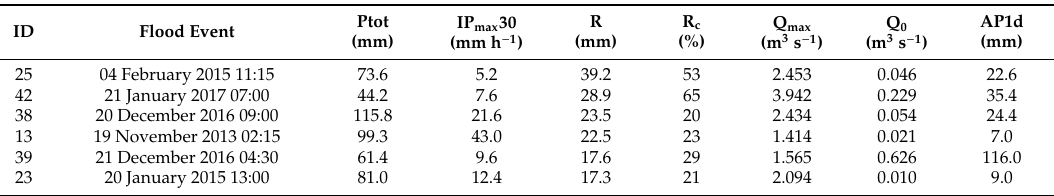
Table A5. Main characteristics of the highest runoff event contribution in Es Fangar Creek during the study period 2012–2017.